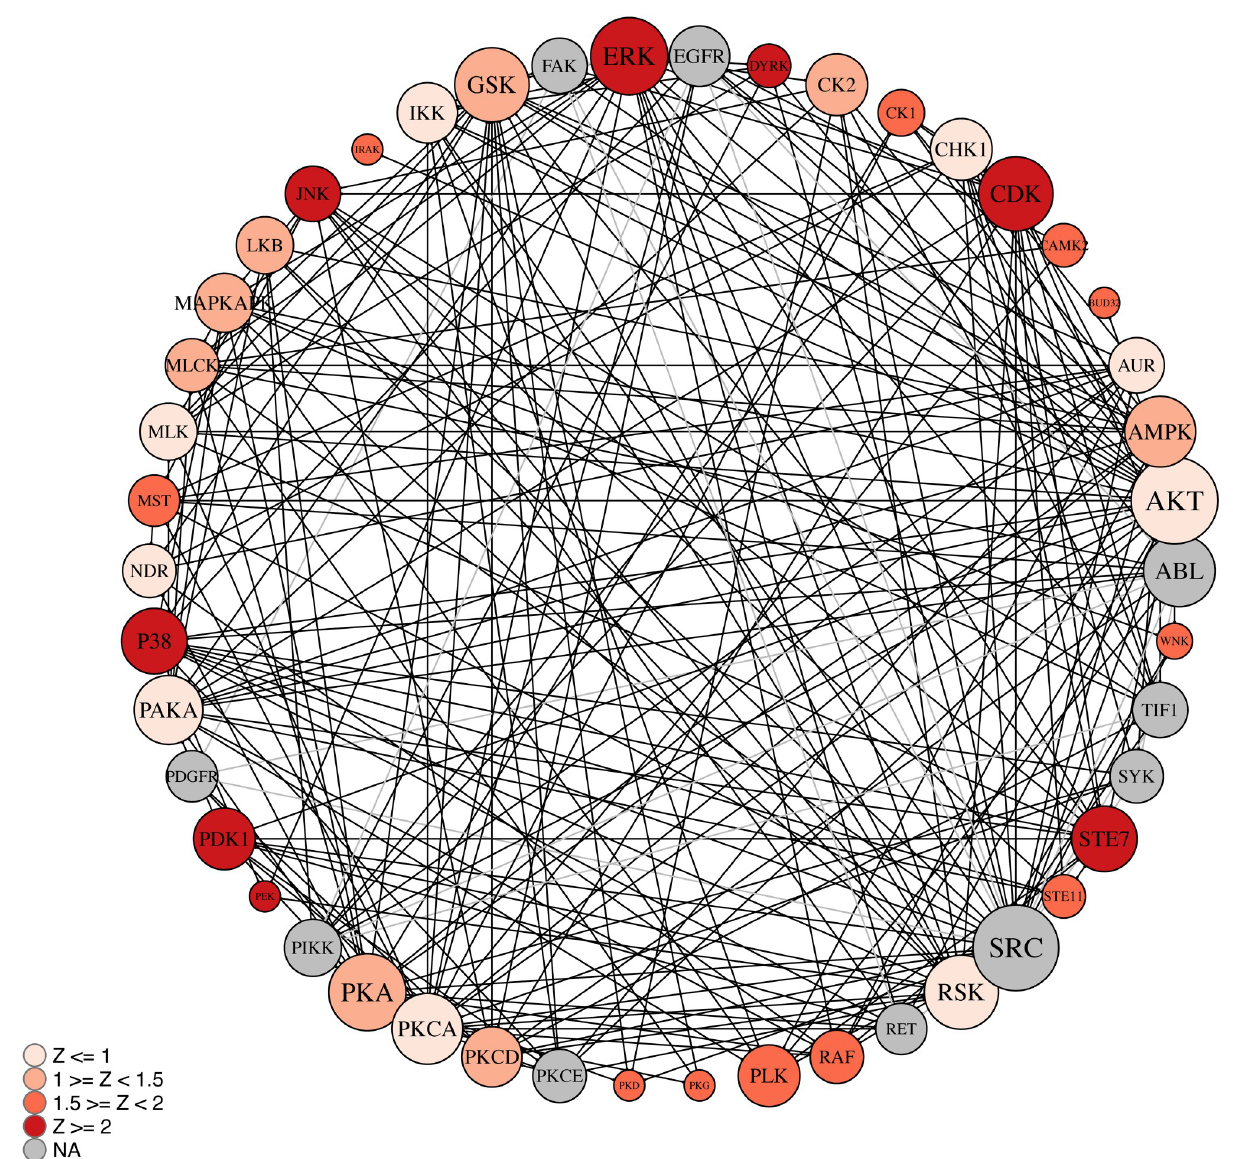
Fig 5. Kinase network model of female vs. male DLPFC. The kinase network was obtained in KRSA by growing the kinome array hits with kinase interacting partners as identified using STRING and PhosphoSitePlus. The kinome array hits are color coded by the averaged z score values. Circle size corresponds to the number of interactions, with larger circles having more interactions. Black lines represent interactions with a kinome array direct hit, while gray represent interactions made between associated the other kinase families.